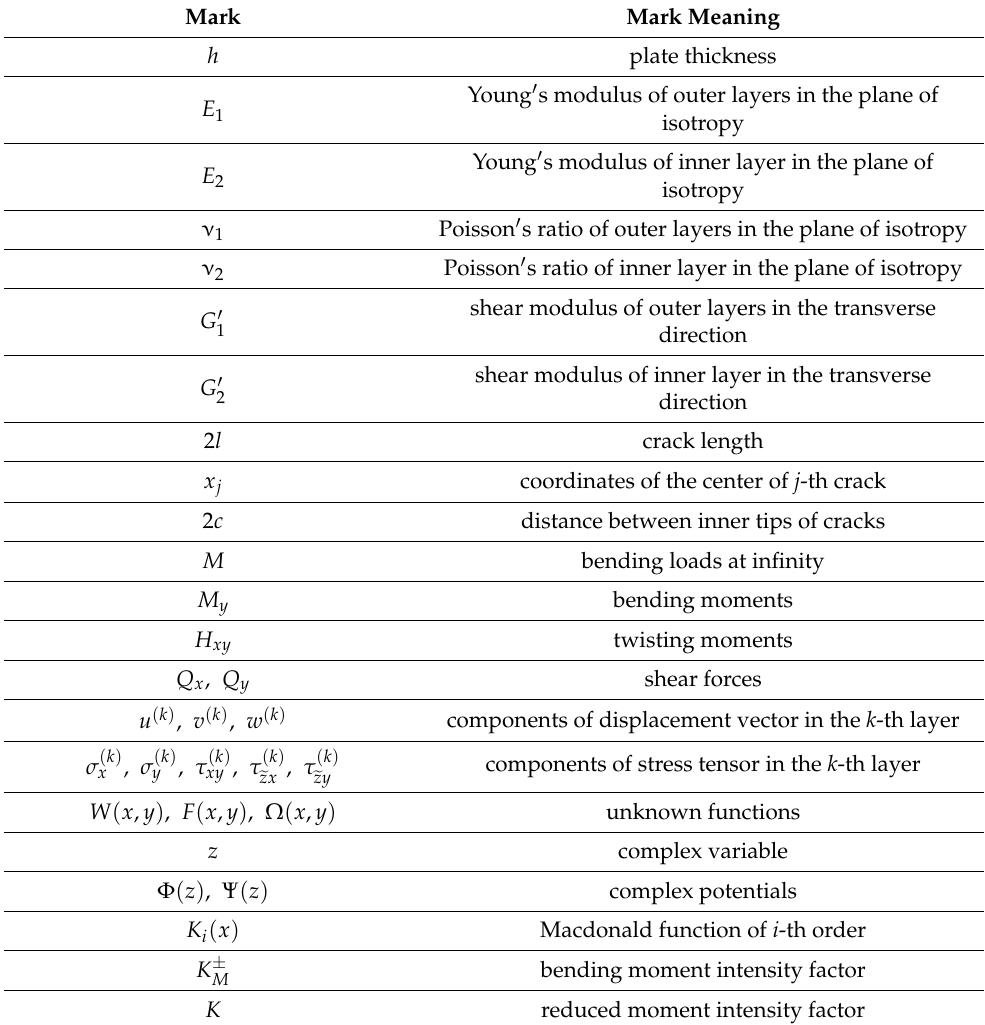
Mark Mark Meaning